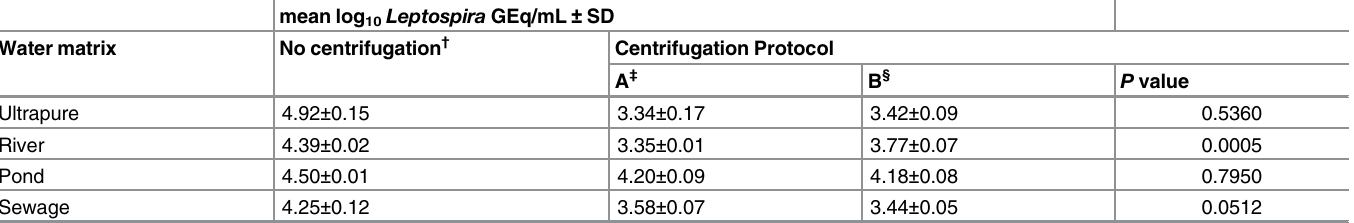
Table 2. Effect of different centrifugation protocols on the recovery of leptospiral DNA from four water samples spiked at 1 × 10 5 Leptospira /mL.